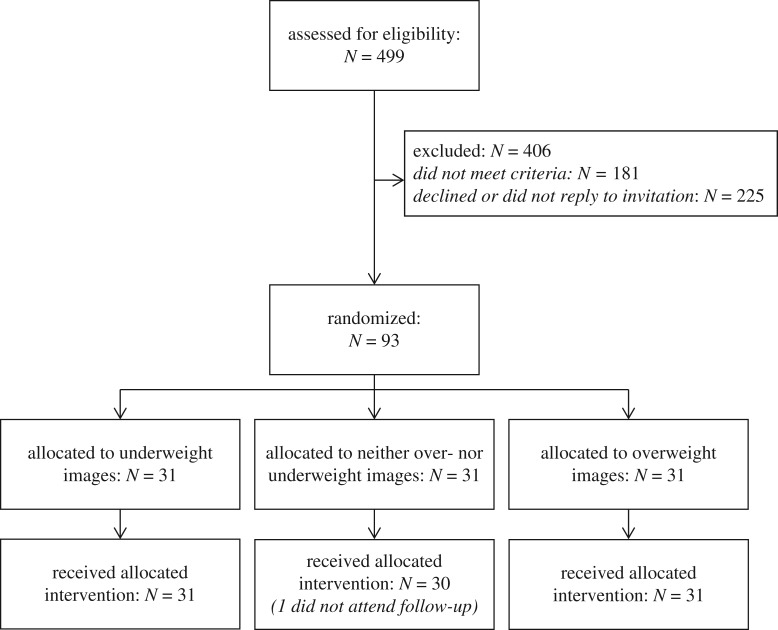
CONSORT diagram.